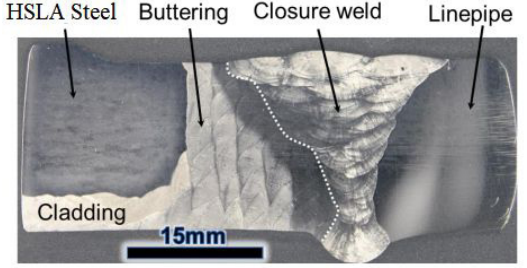
Figure 2. V45º half bevel joint and 10 mm buttery sketch. Table 1. Base (F22) and filler metals (NiCrMo-3 and 309L-Si) chemical composition. Manufacturer data.